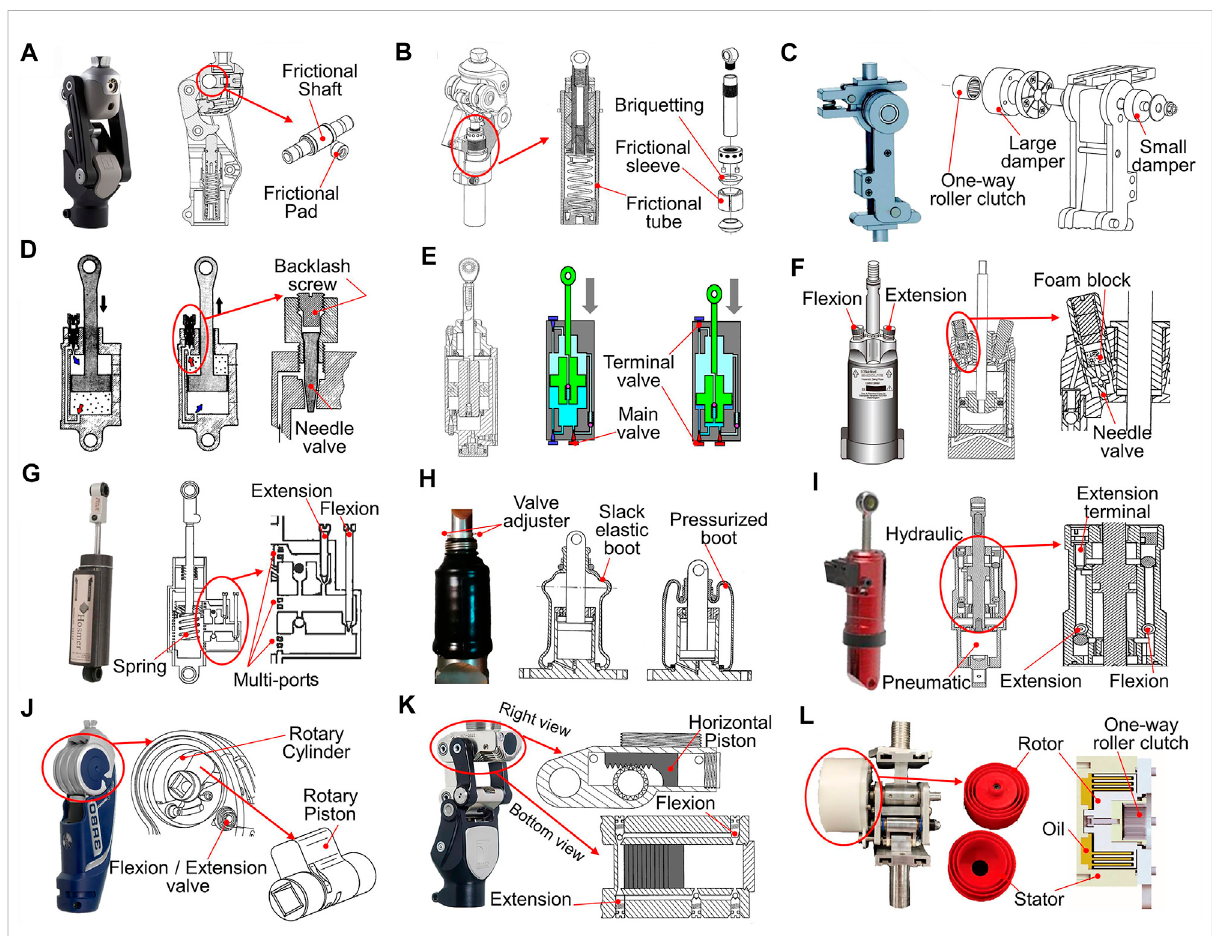
FIGURE 10 Functional components for swing resistance in passive knees. (A) Knee with the frictional elements acting on the pivot axis (Ossur ® Balance, Omarsson et al., 2017), reproduced with permission from copyright 2017 by Ossur ® . (B) Prosthetic knee with the cylindrical frictional elements (Wu, 2011),reproduced withpermission fromcopyright2017 by (F) G.Wu. (C) Prosthetickneewith thedifferentialfrictionalsystem (Arelekattiand Winter, 2015), reproduced with permission from copyright 2015 by MIT. (D) Pneumatic unit with the adjustable backlash at the top of the needle